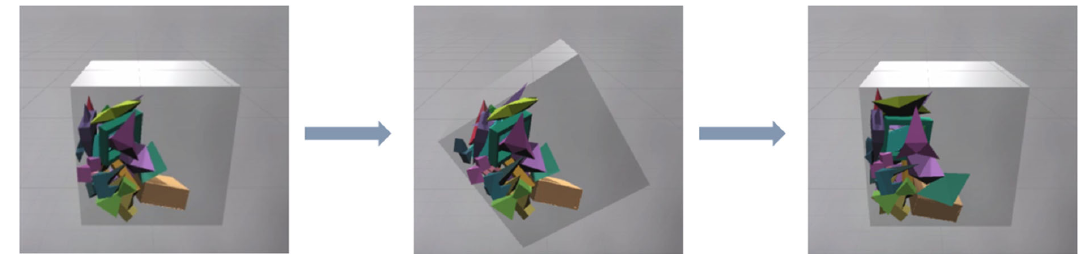
direction using the instance (cid:3051)